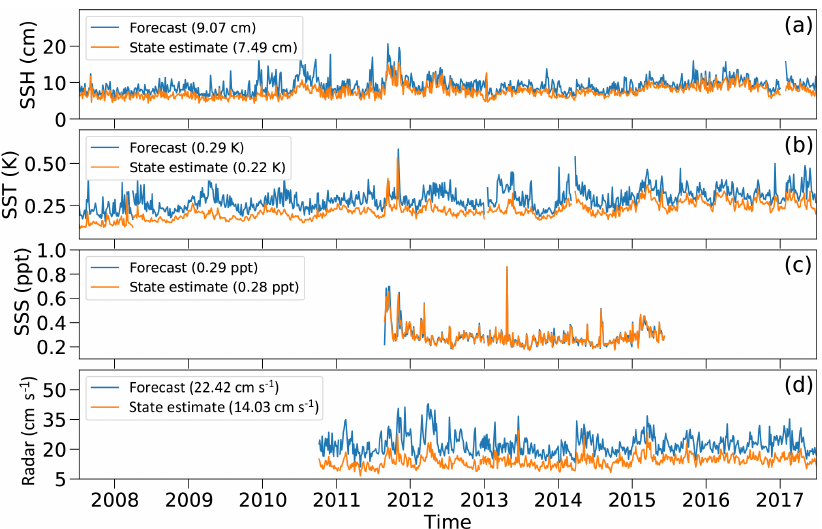
Figure 7. Time series of root mean squared anomalies (RMSAs) between remotely sensed observations and two model realizations: the state estimate (orange) and the forecast (blue). (a) Sea surface height; (b) sea surface temperature; (c) sea surface salinity; and (d)